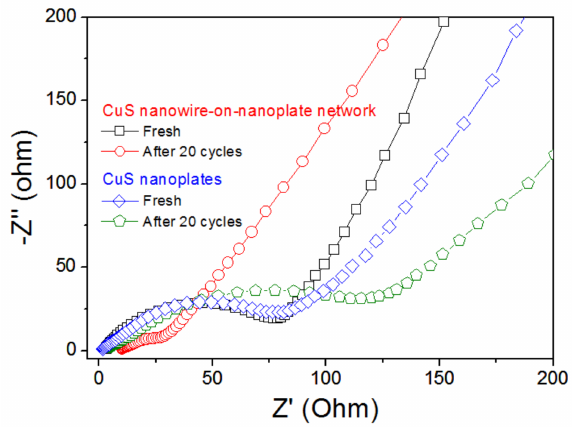
Figure 6. Nyquist plots of CuS